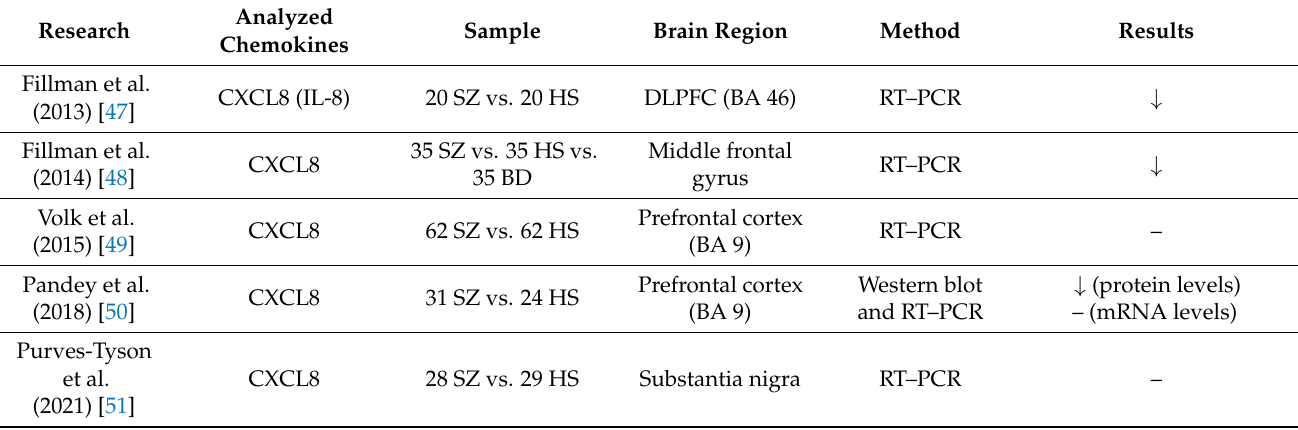
Table 4. Chemokine expression in the brain of patients with